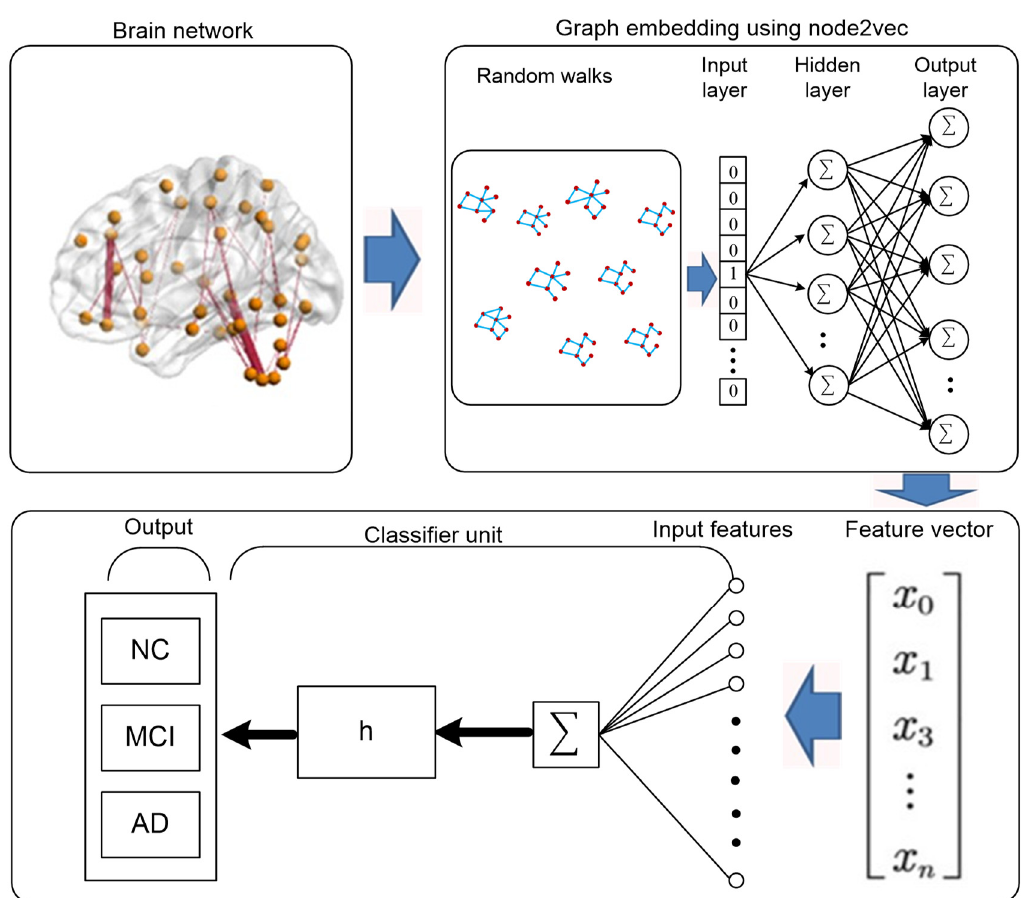
Figure 3. Flowchart of the proposed method.